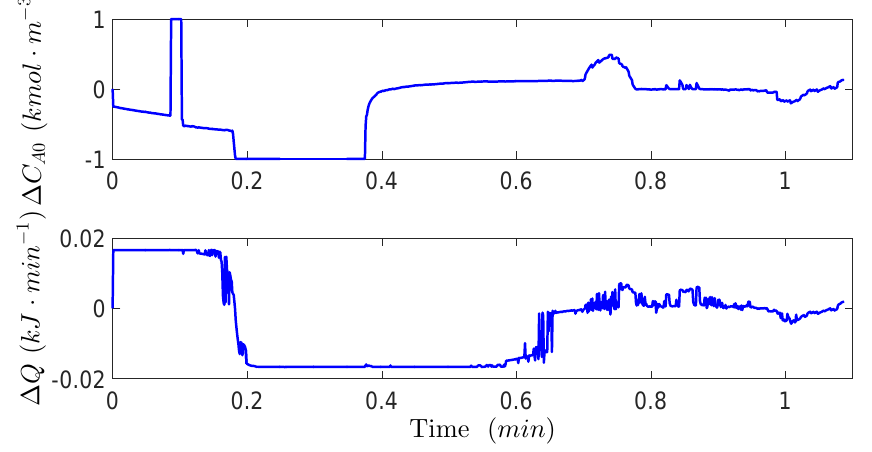
Figure 16. Manipulated input profiles ( u 1 = ∆ C A 0 , u 2 = ∆ Q ) for the closed-loop CSTR with bounded disturbances and the initial condition (0.25, − 3) under the LMPC of Equation